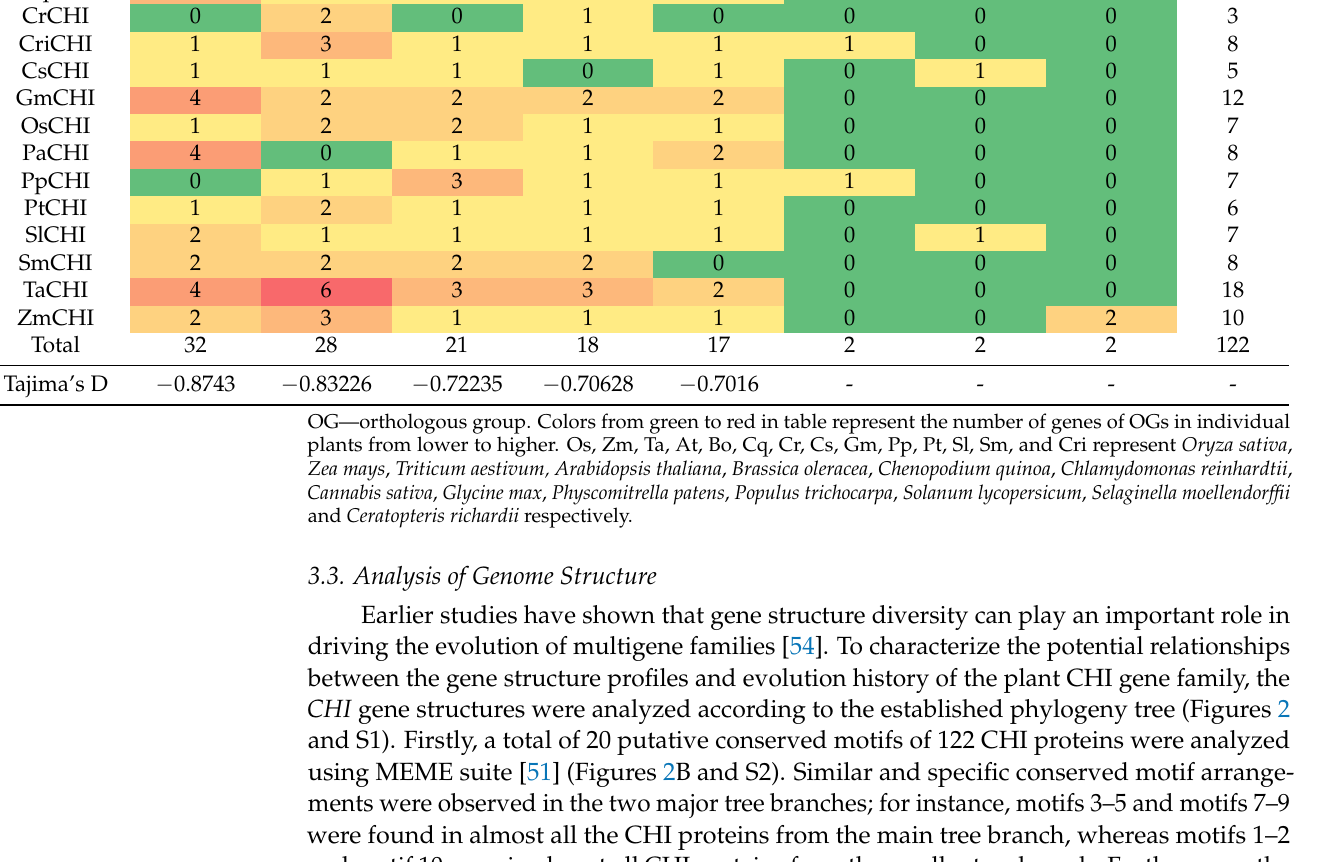
Table 1. Statistics of all orthologous groups (OGs) among 15 green plants.